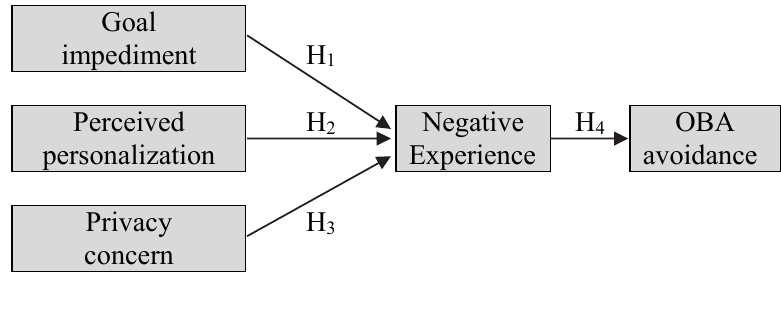
Fig. 1. Conceptual